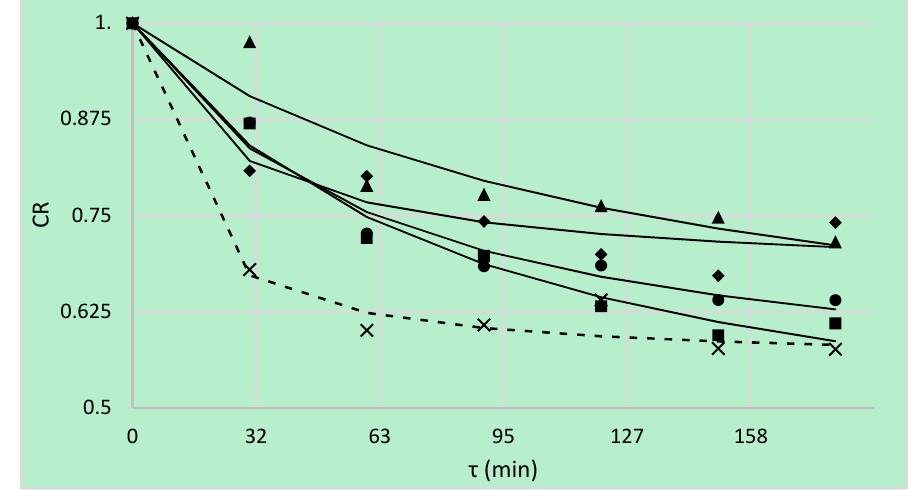
Figure 5. Cichowska’s et al. ratio (CR), kinetics using different solutions: erythritol ( ), xylitol ( ● ), maltitol ( ▲ ), dihydroxyacetone ( ♦ ), sucrose ( × ). Lines are the Peleg’s model. Dotted line is kinetic reference of sucrose.